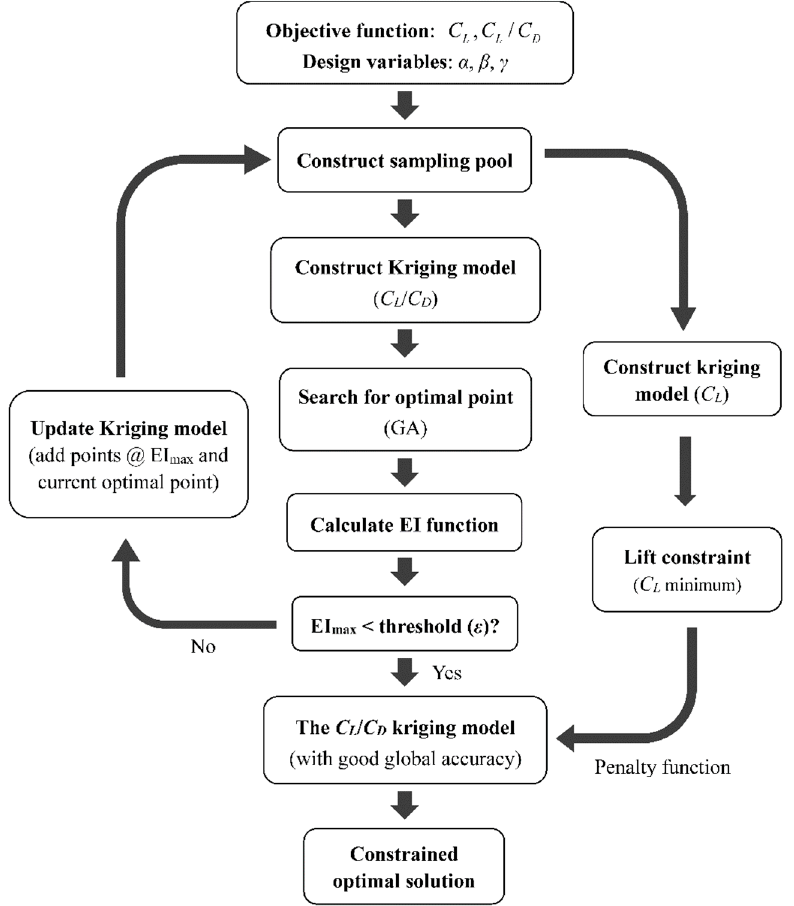
Figure 3. The optimization procedure of the current research.